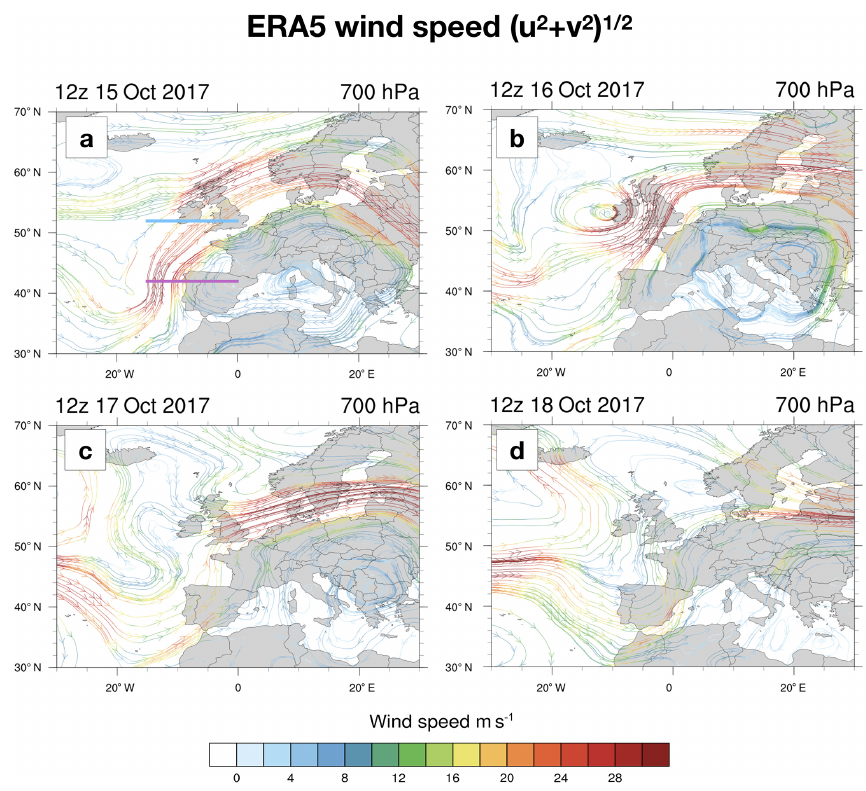
Figure 3. Stream functions coloured by ERA5 wind speed intensity at a 700hPa pressure level at 12:00UTC on 15 (a) , 16 (b) , 17 (c) , and 18 (d) October 2017. Teal and magenta lines in (a) represent the position of the cross sections of winds speed/meridional wind shown in Fig. 4.